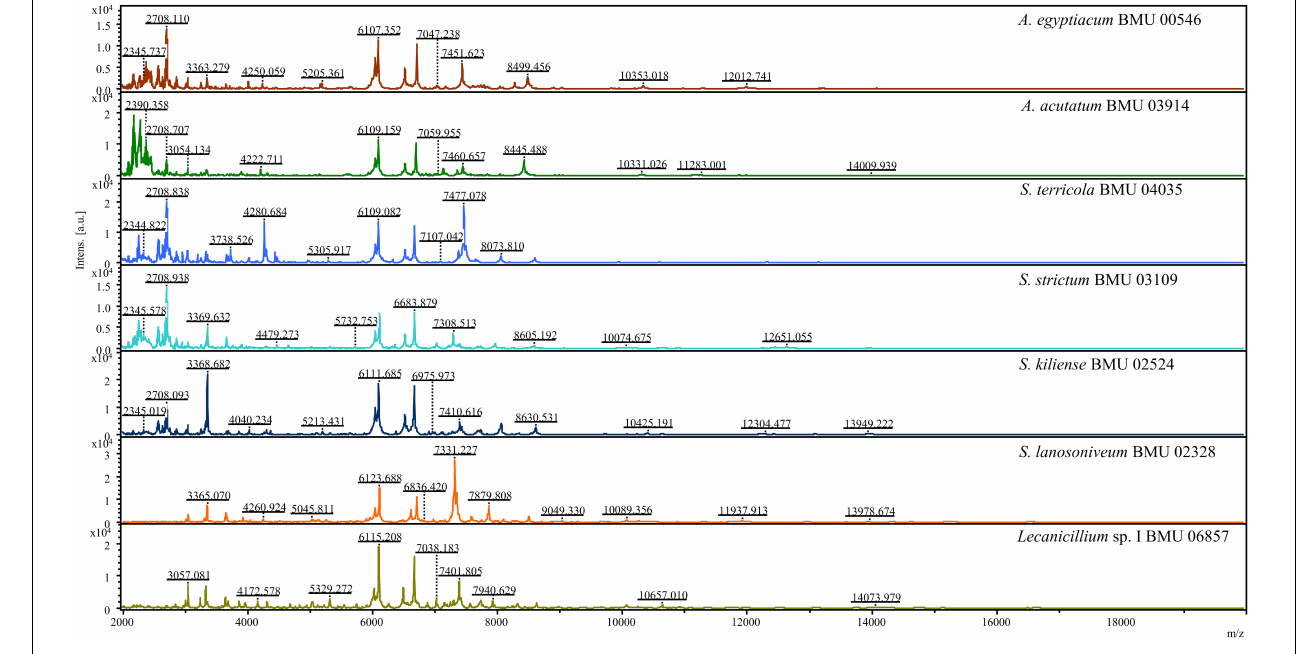
Biotyper RTC 4.0 software (Bruker Daltonik, Bremen,